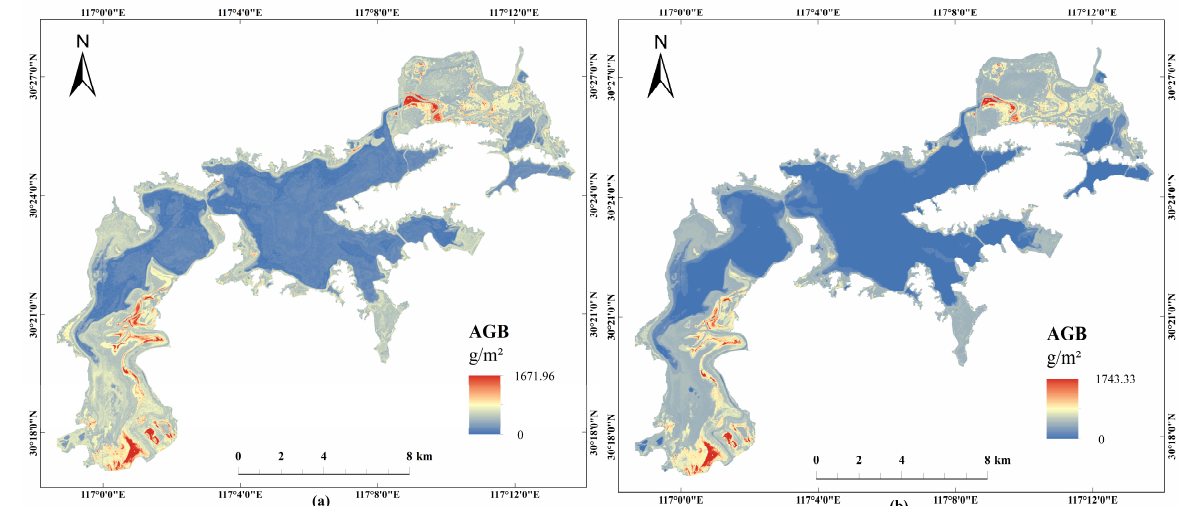
Figure 6. Spatial distribution of estimated AGB in the Shengjin Lake wetland using ensemble learning algorithms, including ( a ) the RF model and ( b ) the XGBoost model.